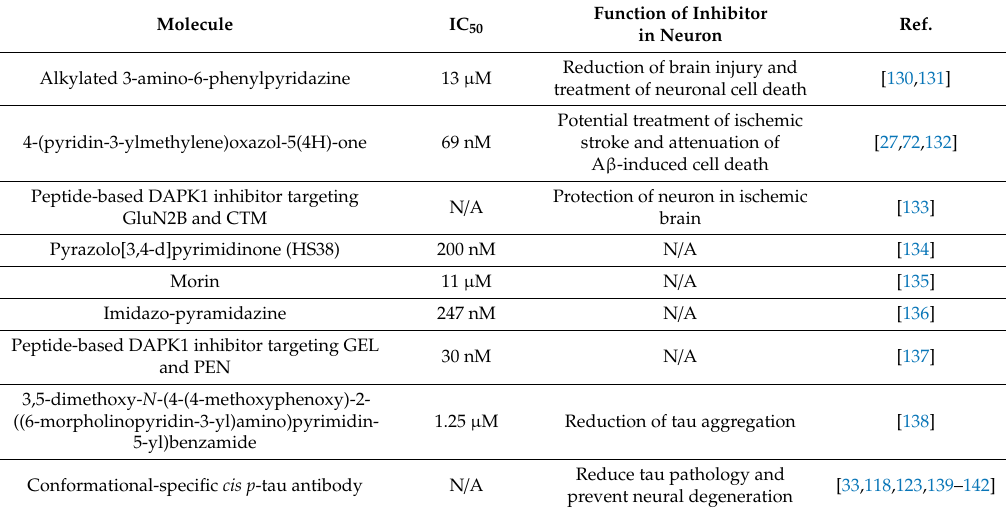
Table 1. Potential inhibitors related with